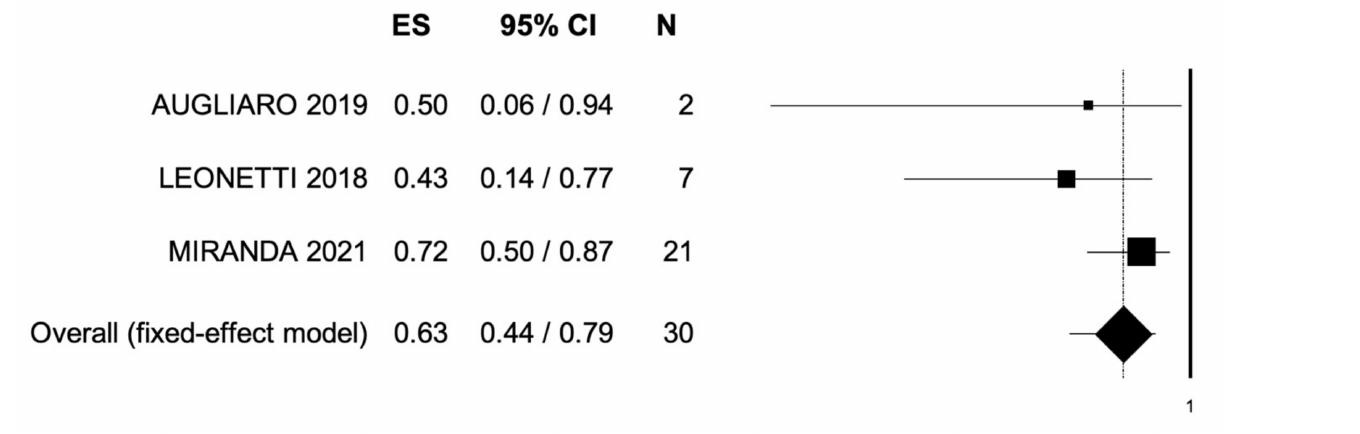
Figure 2. Forest plot showing the event rate for Overall Response Rate. ES, effect size; CI, confidence interval. (I 2 = 0.00, p = 0.368.)